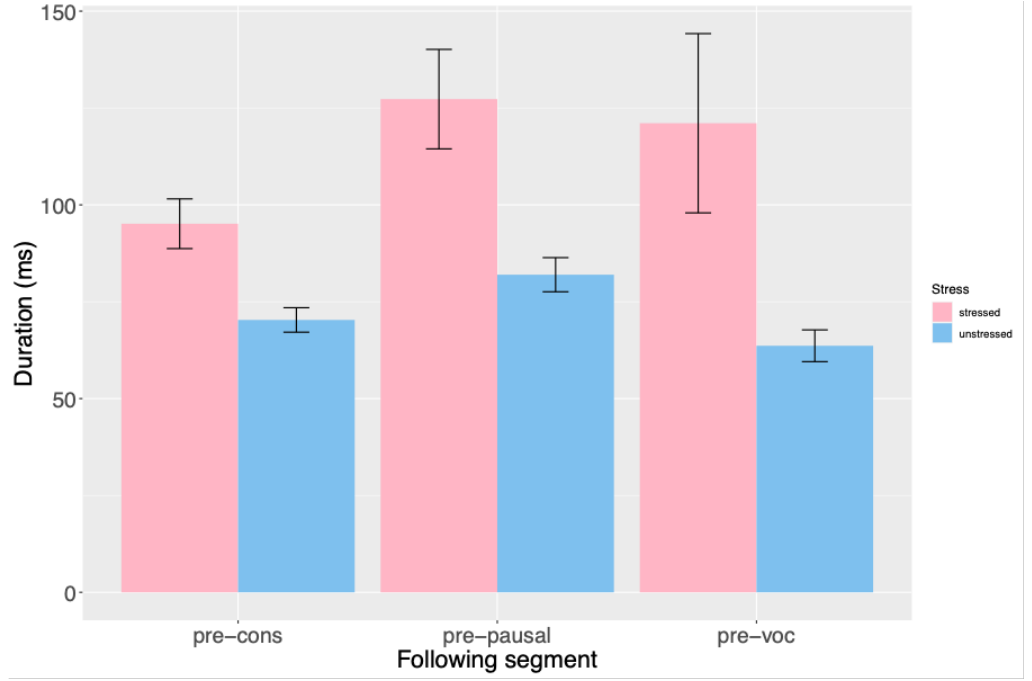
Figure 8. Mean duration (milliseconds) for vowels in unstressed, closed syllables in pre-con- sonantal, pre-pausal and pre-vocalic contexts